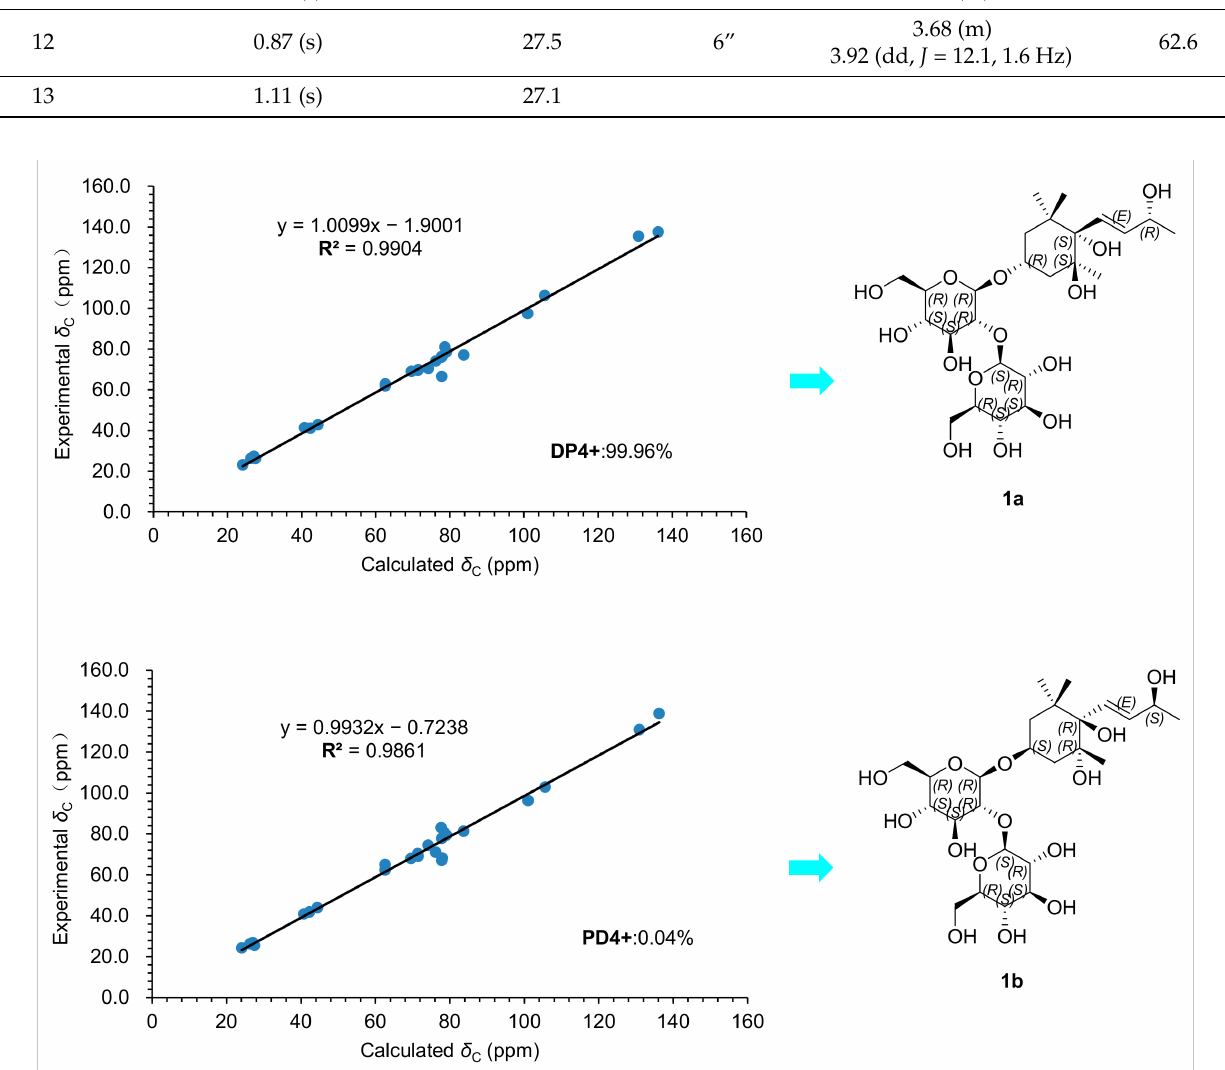
Figure 3. The 13 C NMR calculations of 1a and 1b